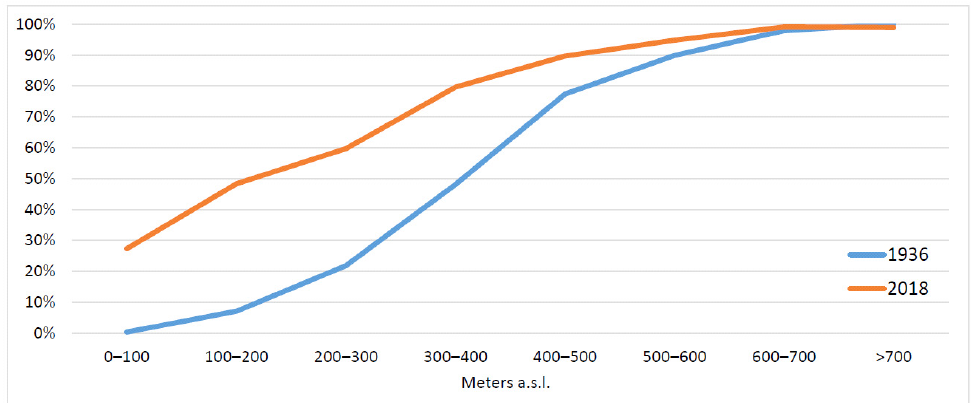
Figure 3. Percentages of the total surface of the Cinque Terre National Park occupied by forests in 1936 and in 2018 according to different altitudinal ranges.